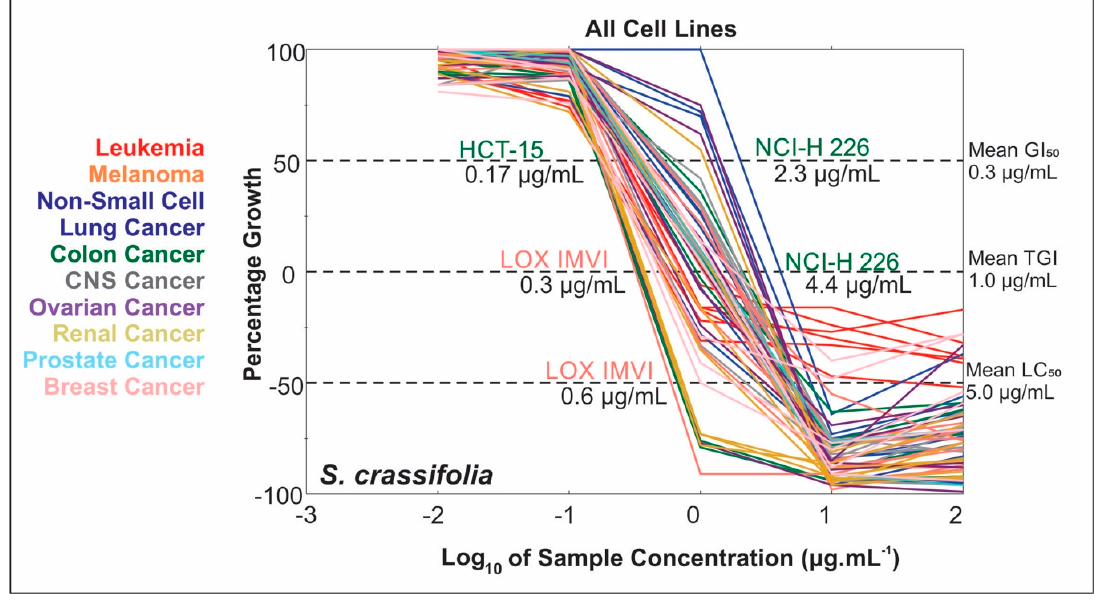
Figure 1. NCI-60 dose-response curves for the Salacia crassifolia root wood extract. Percentage growth of 100: cell growth is comparable to the control; percentage growth of 0: cells are still viable but no net cell growth relative to time zero; percentage growth of − 100: complete cell killing, no cells are viable.